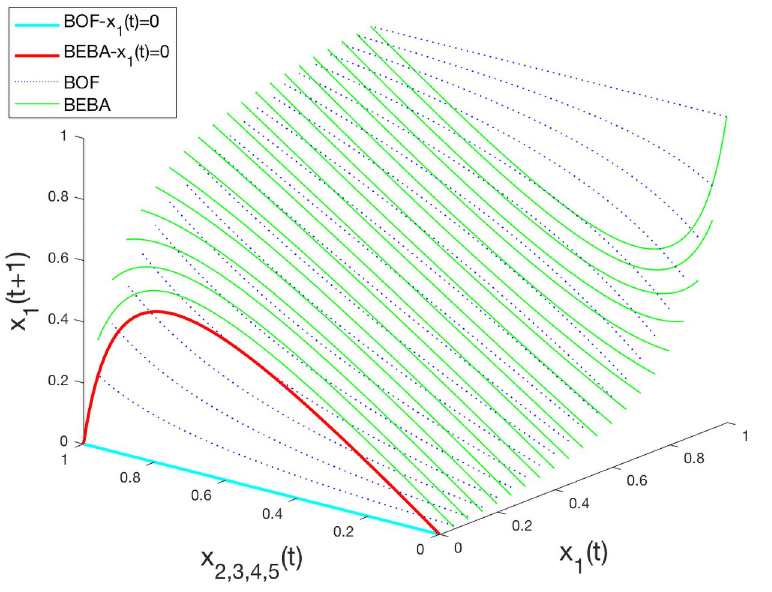
Fig 1. Opinion formation on the star graph.